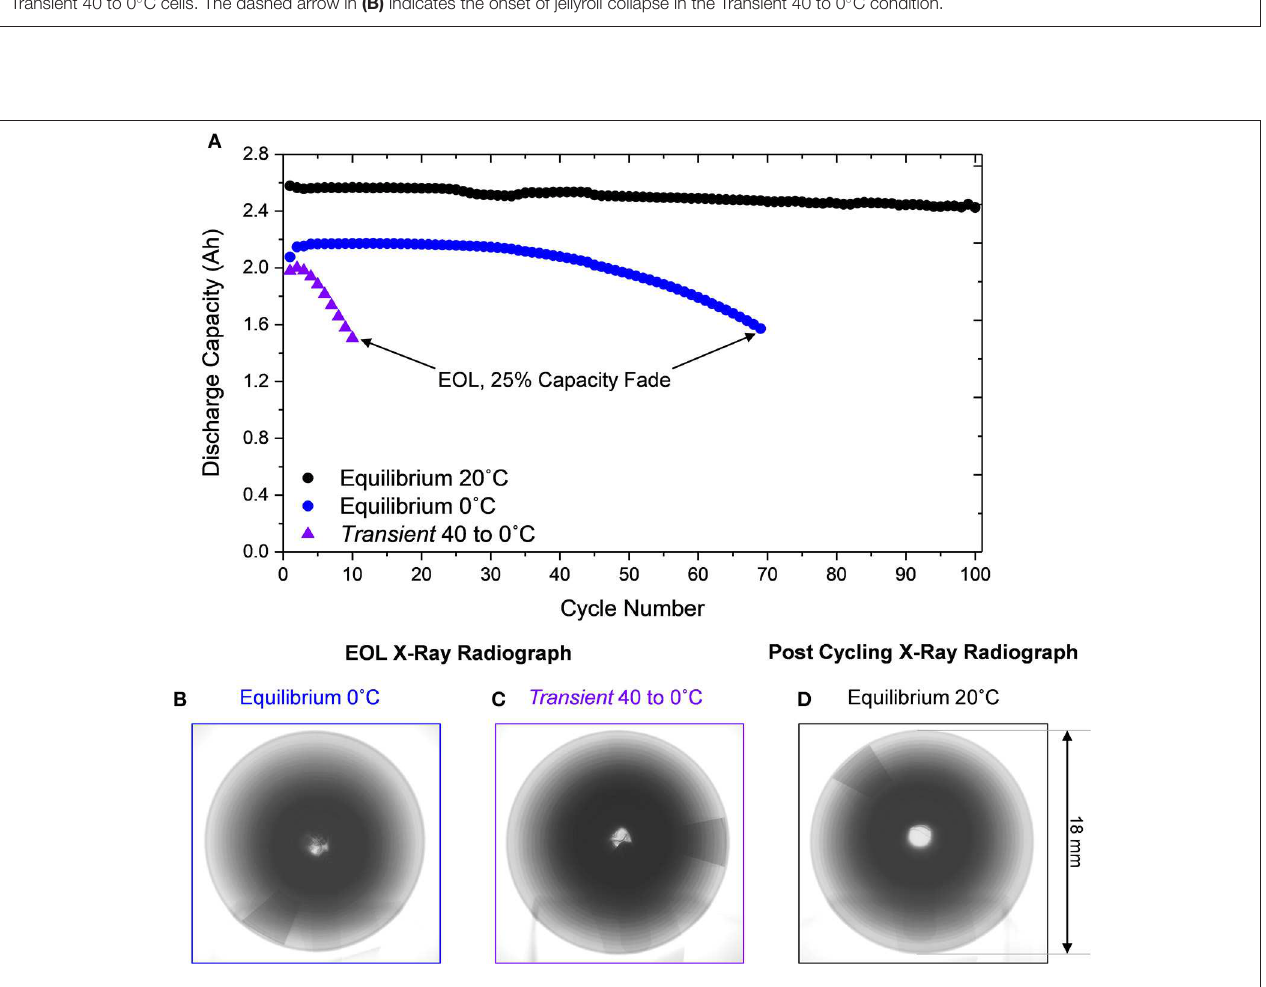
FIGURE 7 | (A) Discharge capacity of Equilibrium 20 ◦ C over 100 cycles and Equilibrium 0 ◦ C and Transient 40 to 0 ◦ C cells to 25% capacity fade. X-ray radiograph after 30% capacity fade for cells subjected to (B) Equilibrium 0 ◦ C and (C) Transient 40 to 0 ◦ Cwith evidence of jellyroll collapse, contrasted to the Equilibrium 20 ◦ C cell cycled 100 times without mechanical degradation (D)